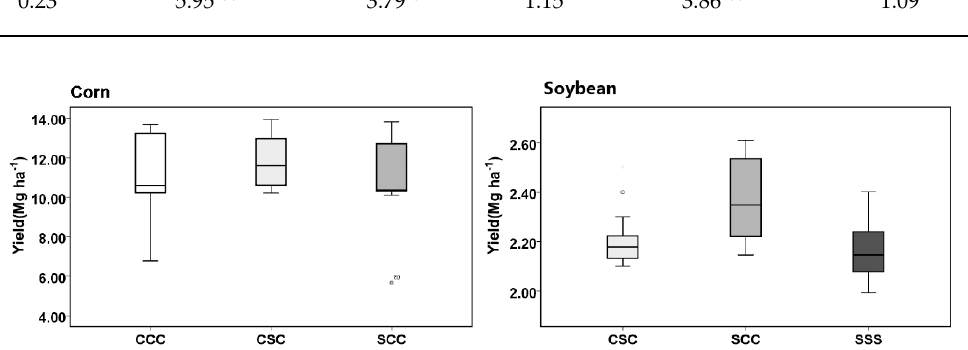
Figure 1. Boxplot of yield for corn and soybean under different crop rotations. Crop rotation treatments include continuous corn (CCC), corn − soybean − corn (CSC), soybean − corn − corn (SCC), and continuous soybean (SSS). ○ are outliers wich scores greater than 1.5 times the interquartile range are out of the boxplot .